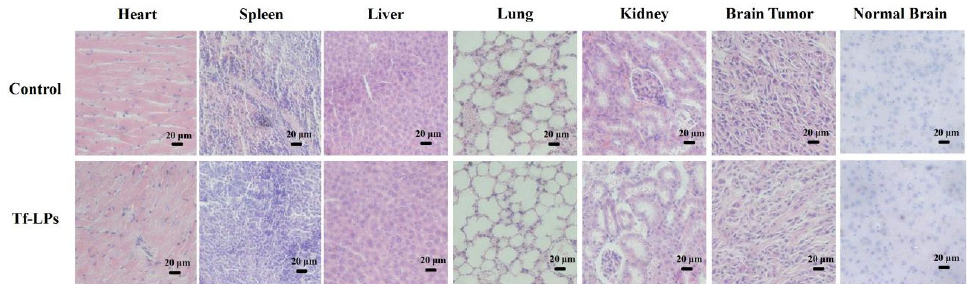
Figure 9. Histological analysis of mice treated with Tf-LPs. Tf-LPs groups showed that no abnormality mality in organs examined, suggesting the safety of Tf ‐ LPs. Abbreviations: LPs, DOX ‐ loaded lipo ‐ in these organs were provided, suggesting the safety of Tf-LPs. Abbreviations: LPs, DOX-loaded somes; Tf ‐ LPs, DOX ‐ loaded Tf ‐ liposomes. liposomes; Tf-LPs, DOX-loaded